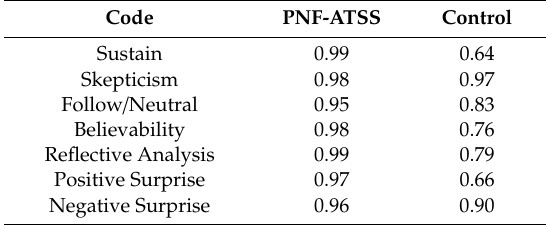
Table 2. Interrater reliability using Intraclass Correlation Coe ffi cients (ICCs) based on absolute agreement criterion.